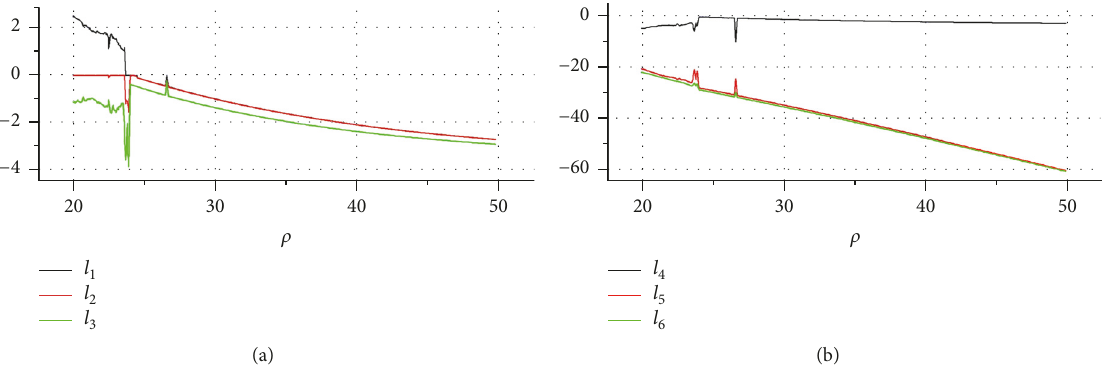
Figure 1: The Lyapunov exponents 𝑙 𝐼 , 𝐼 = 1, 2, .. ., 6 of system (3) when we fix 𝜐 = 10 and 𝜇 = 6 and vary 𝜌 ∈ [20,50].